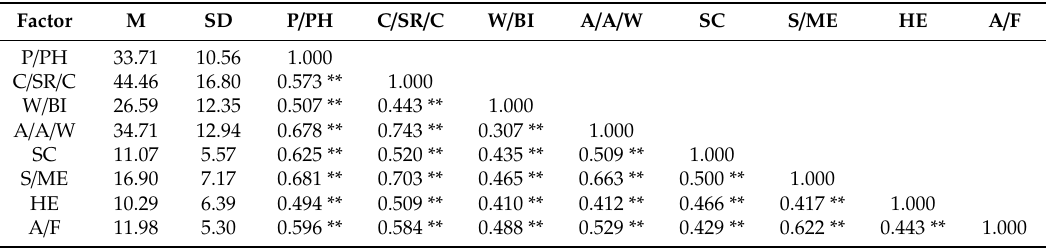
Table 1. Means, standard deviations, and correlations of motivational factors towards the practice of physical